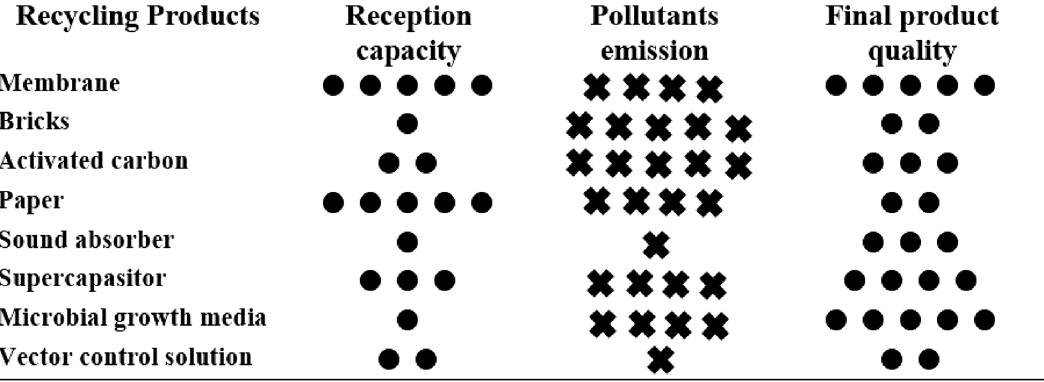
Figure 5. Characteristics of products from CB